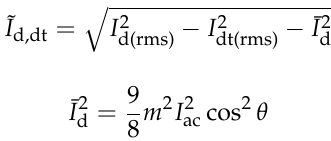
Figure 3. Input current waveform of a three-phase VSI (case 1: θ ≤ 30 ◦ ) for intervals: ( a ) π ≤ ω t ≤ π + π ; ( b ) θ + π 3 3 2